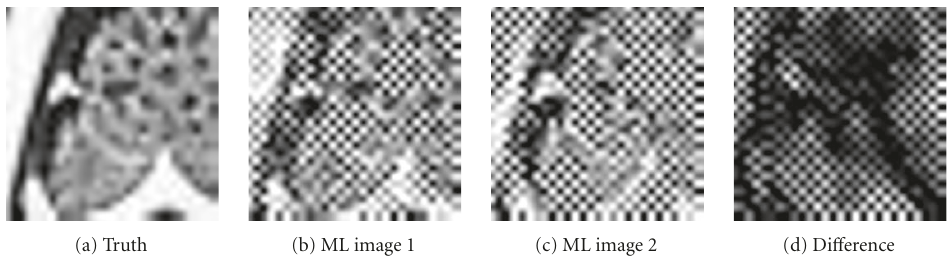
Figure 2: An example of the e ff ect of tiny changes in the registration parameters. (a) Ground truth image from which a 16-image low- resolution dataset was generated. (b), (c) Two ML super-resolution estimates. In both cases, the same dataset was used, but the registration parameters were perturbed by an i.i.d. vector with standard deviation of just 0.04 low-resolution pixels. (d) The di ff erence between the two solutions. In all these images, values outside the valid image intensity range have been rounded to white or black values.